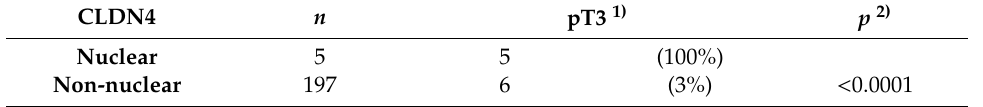
Table 2. Nuclear CLDN4 expression in renal cell carcinomas.